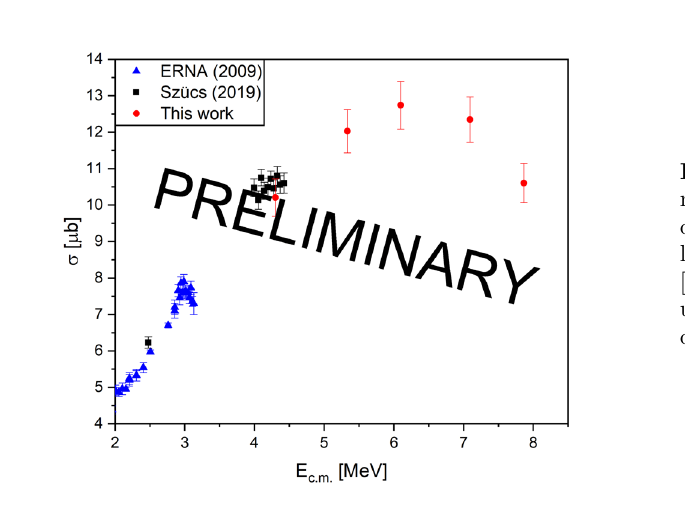
Figure 1. The new preliminary data compared to literature values [7, 11]. The total uncertainty of the data is